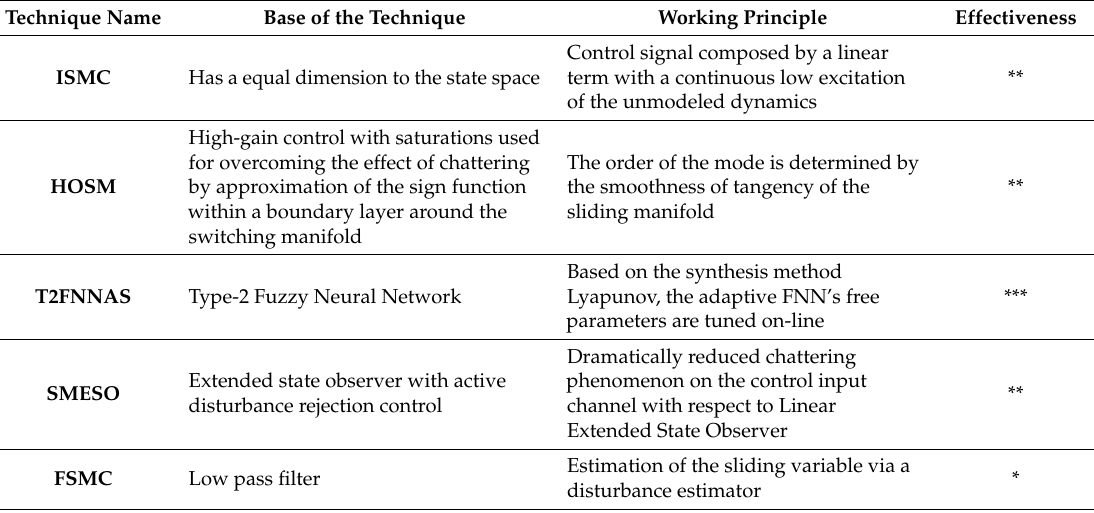
Table 3. Methods to improve SMC